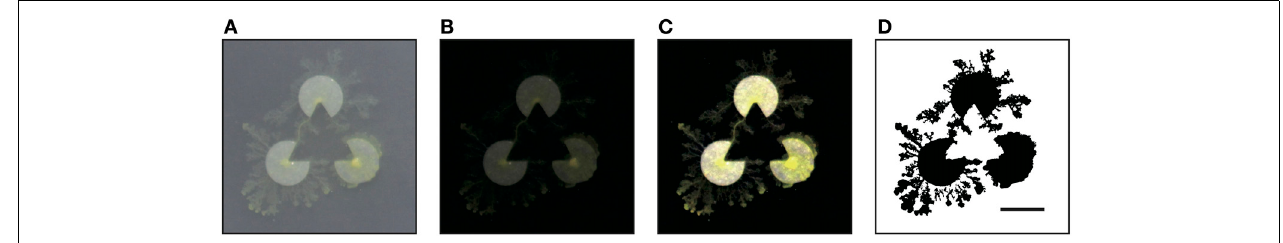
FIGURE 5 | Experiment using real Physarum (scale bar: 10mm). The radius of a pac-man was 5mm, and the distance between the centers of two pac-men was 15mm. (A) The captured image. (B) Obtained by subtracting the background of (A) . (C) Adjusted the brightness. (D)